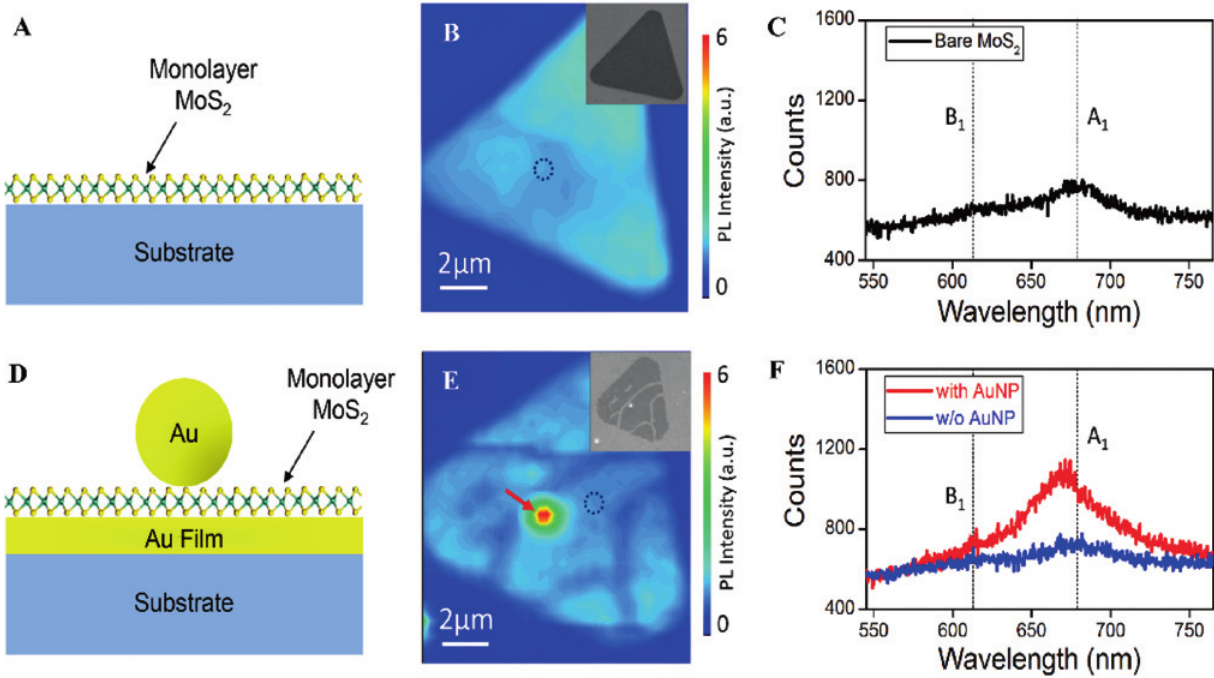
Figure 1: (A) Schematic representation of monolayer MoS 2 on a bare substrate. (B) PL intensity map and SEM image of monolayer MoS 2 on a bare substrate. (C) PLspectra of monolayer MoS 2 in (B)(blackdashed circle).(D) Schematicrepresentation of monolayer MoS 2 on AuFilmwith AuNP. (E)PLintensity mapand SEMimage of monolayerMoS 2 with AuNP andAuFilm. (F) PL spectraof monolayerMoS 2 on theAuFilmwith and without AuNPs (red and blue curves, respectively), corresponding to (E) (red arrow and black dashed circle,